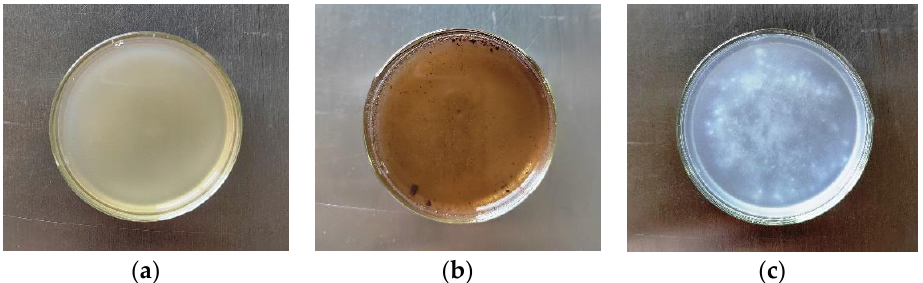
Figure 1. Mussel samples after treatment using three digestion agents: ( a ) 10% KOH; ( b ) 1 + 1 HCl; ( c ) 30% H 2 O 2 .